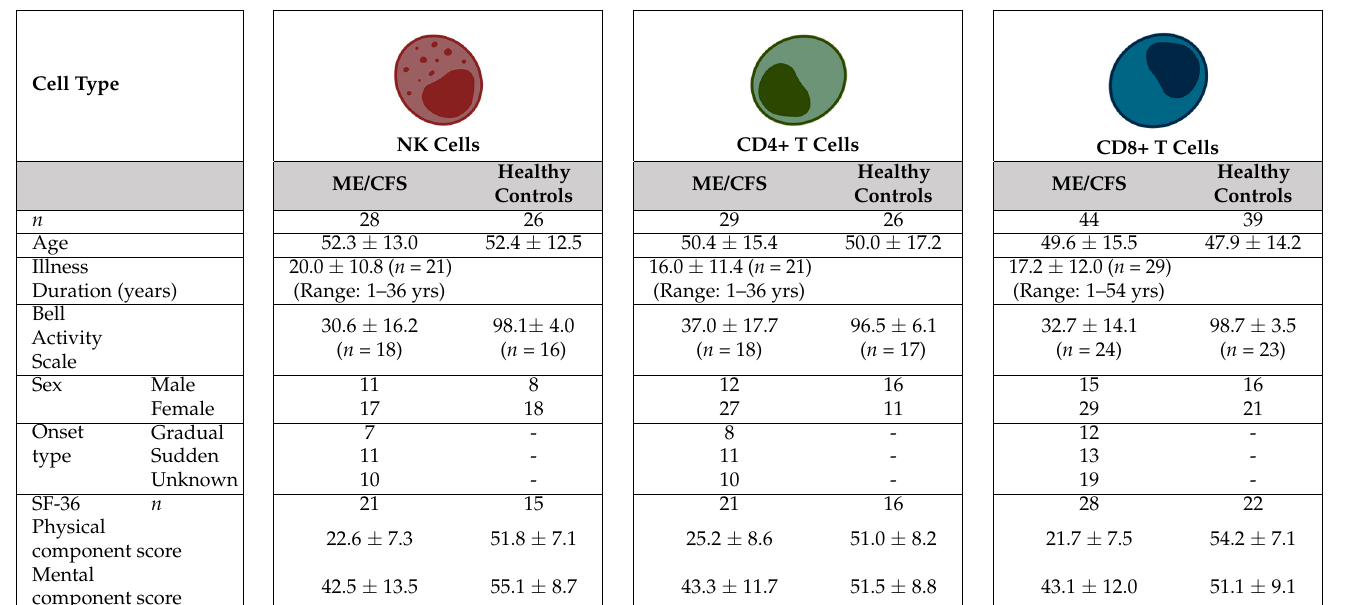
Table 1. Study population demographics and survey data by cell type analyzed.